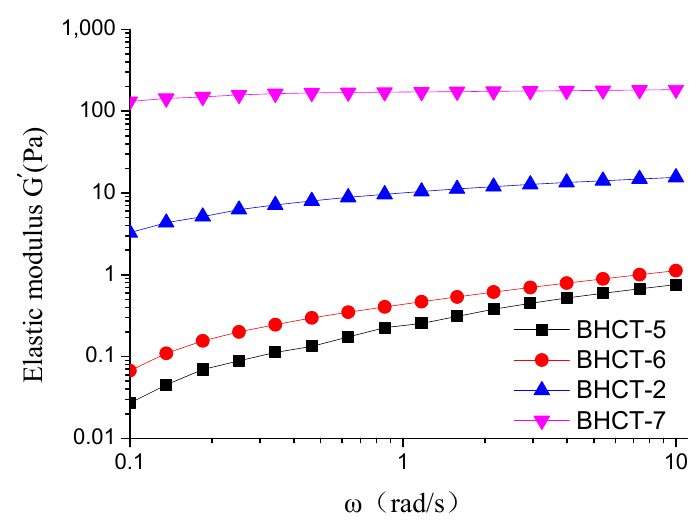
Figure 11. Elastic modulus of composite gels with di ff erent bentonite contents.